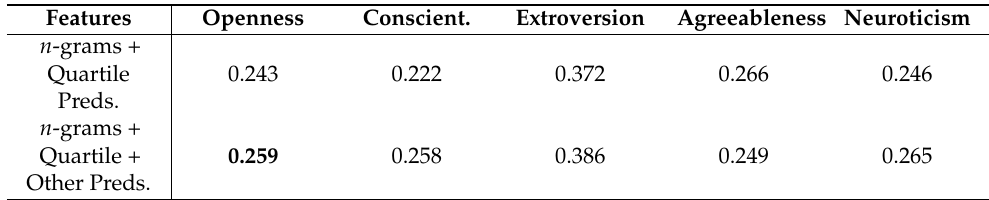
Table 9. Pearson correlation coefficient between the actual Big Five traits and predictions achieved through the usage of n -grams, MBTI/Enneagram predictions and quartile-split Big Five class predic- tions as features.